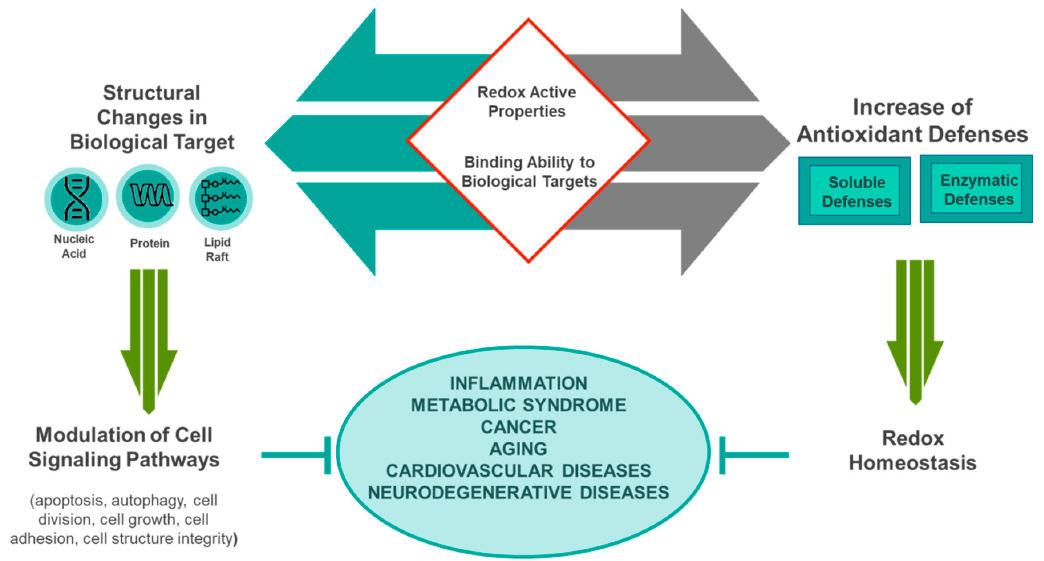
Figure 1. Biochemical mechanisms of phytochemical bioactivity .